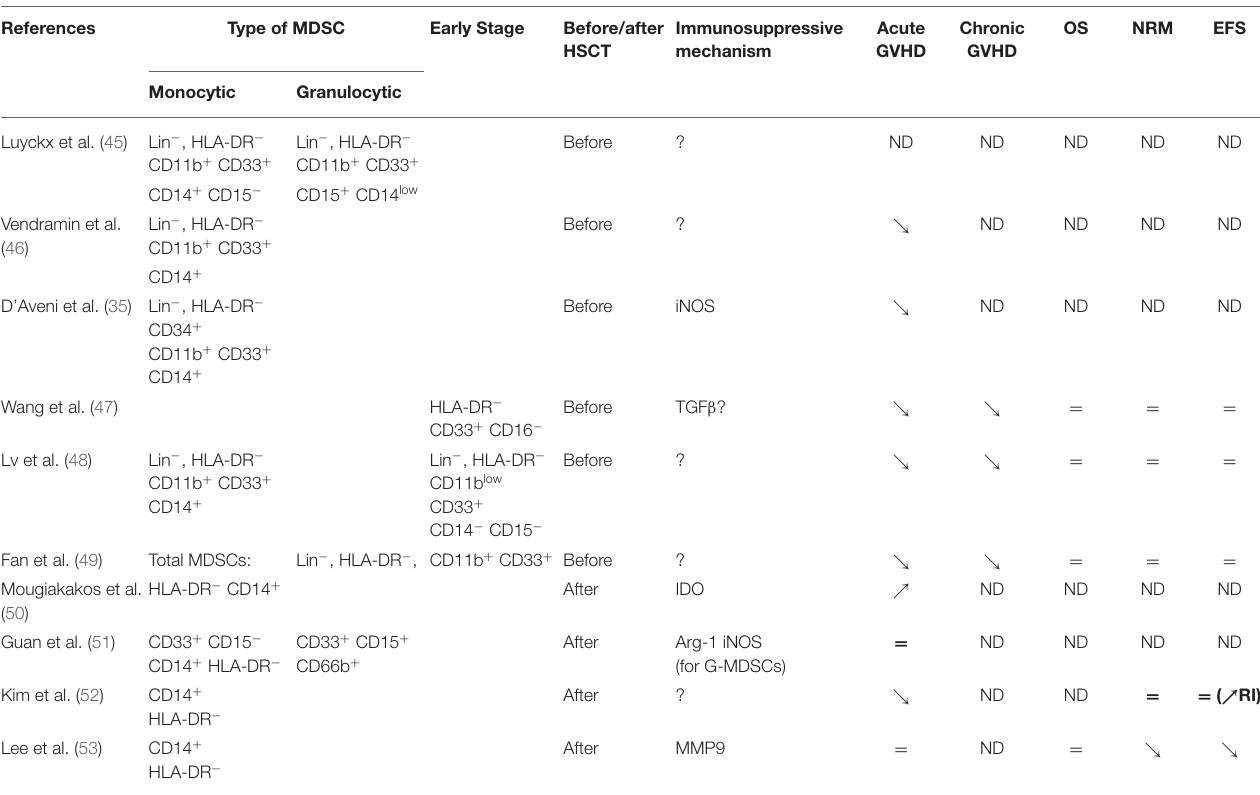
TABLE 2 | MDSCs in the setting of human allogeneic